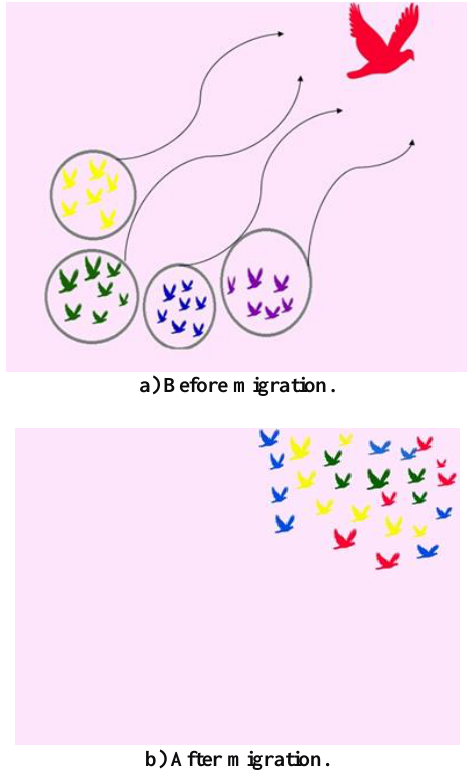
Figure 3. Migration in classical cuckoo